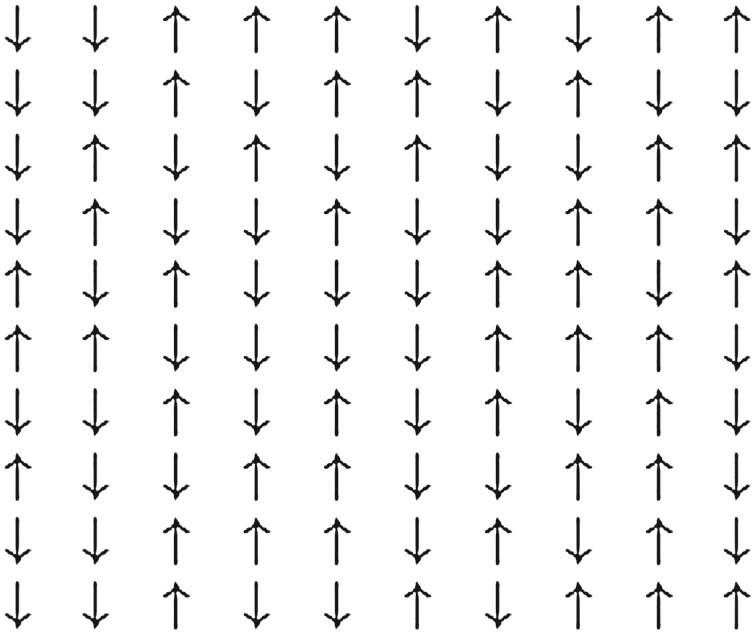
An Ising spin configuration.